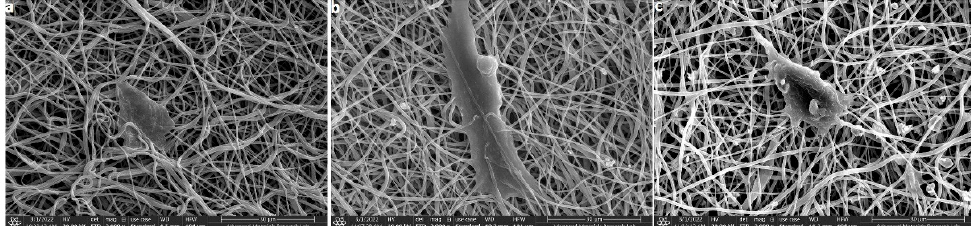
Figure 8. Representative FE-SEM images of the hDPSCs attachment and spreading on ( a ) PCL, ( b ) PCLHA, and ( c ) PCLMTA.